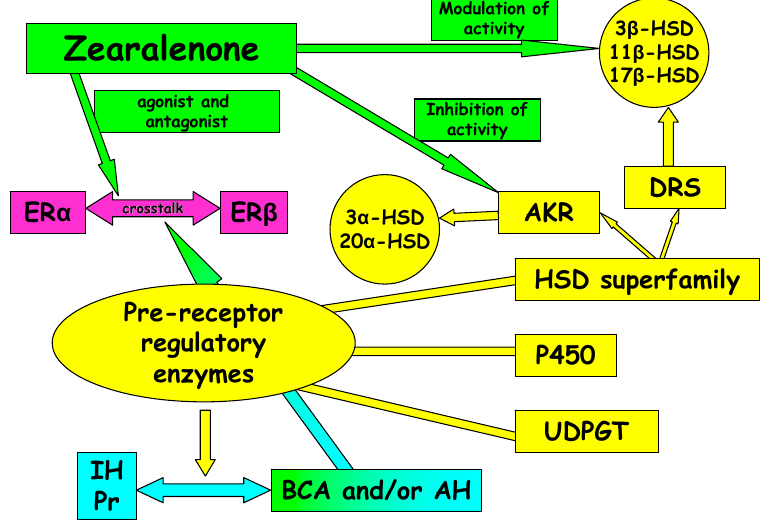
Figure 2. Estrogen receptors and the activation of pathways involved in rapid estrogen signaling. IH, inactive hormone; Pr, precursor; BCA, biologically active compound; AH, active hormone; HSDs, hydroxysteroid dehydrogenases; AKR, aldo-keto reductase superfamily; DRS, dehydrogenase/reductase superfamily; UDPGT, uridine diphosphate glucuronosyltransferase; 3 α -HSD, 3 α -hydroxysteroid dehydrogenase; 3 β -HSD, 3 β -hydroxysteroid dehydrogenase; 11 β -HSD, 11 β -hydroxysteroid dehydrogenase; 17 β -HSD, 17 β -hydroxysteroid dehydrogenase; 20 α -HSD, 20 α -hydroxysteroid dehydrogenase; P450, cytochrome